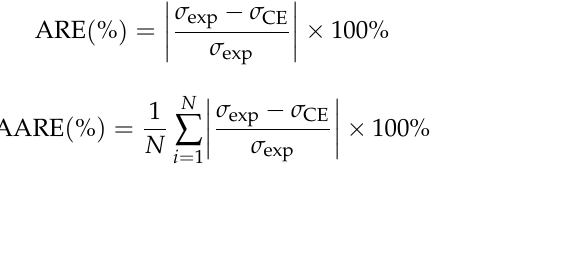
Figure 12. Modified Arrhenius modeling results from the experimental data at different temperatures and strain rates. ( a ) T = 950 °C; ( b ) T = 1000 °C; ( c ) T = 1050 °C; ( d ) T = 1100 °C. In order to evaluate the accuracy of the constitutive models, the absolute relative error (ARE), the average absolute relative error (AARE), and the correlation coefficient (R 2 ) are used as essential references. ARE ， AARE, and R 2 values can be calculated by: ARE(%) = (cid:4708)𝜎 (cid:2915)(cid:2934)(cid:2926) − 𝜎 (cid:2887)(cid:2889) 𝜎 (cid:2915)(cid:2934)(cid:2926)